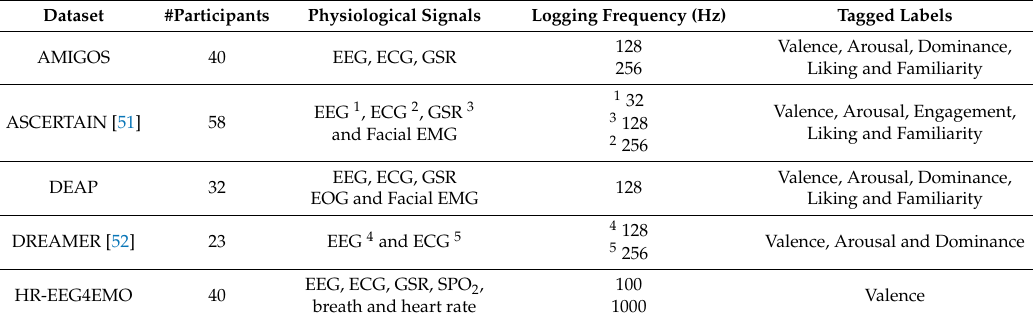
Table 1. Datasets summary (superscripts indicate logging frequency for the used